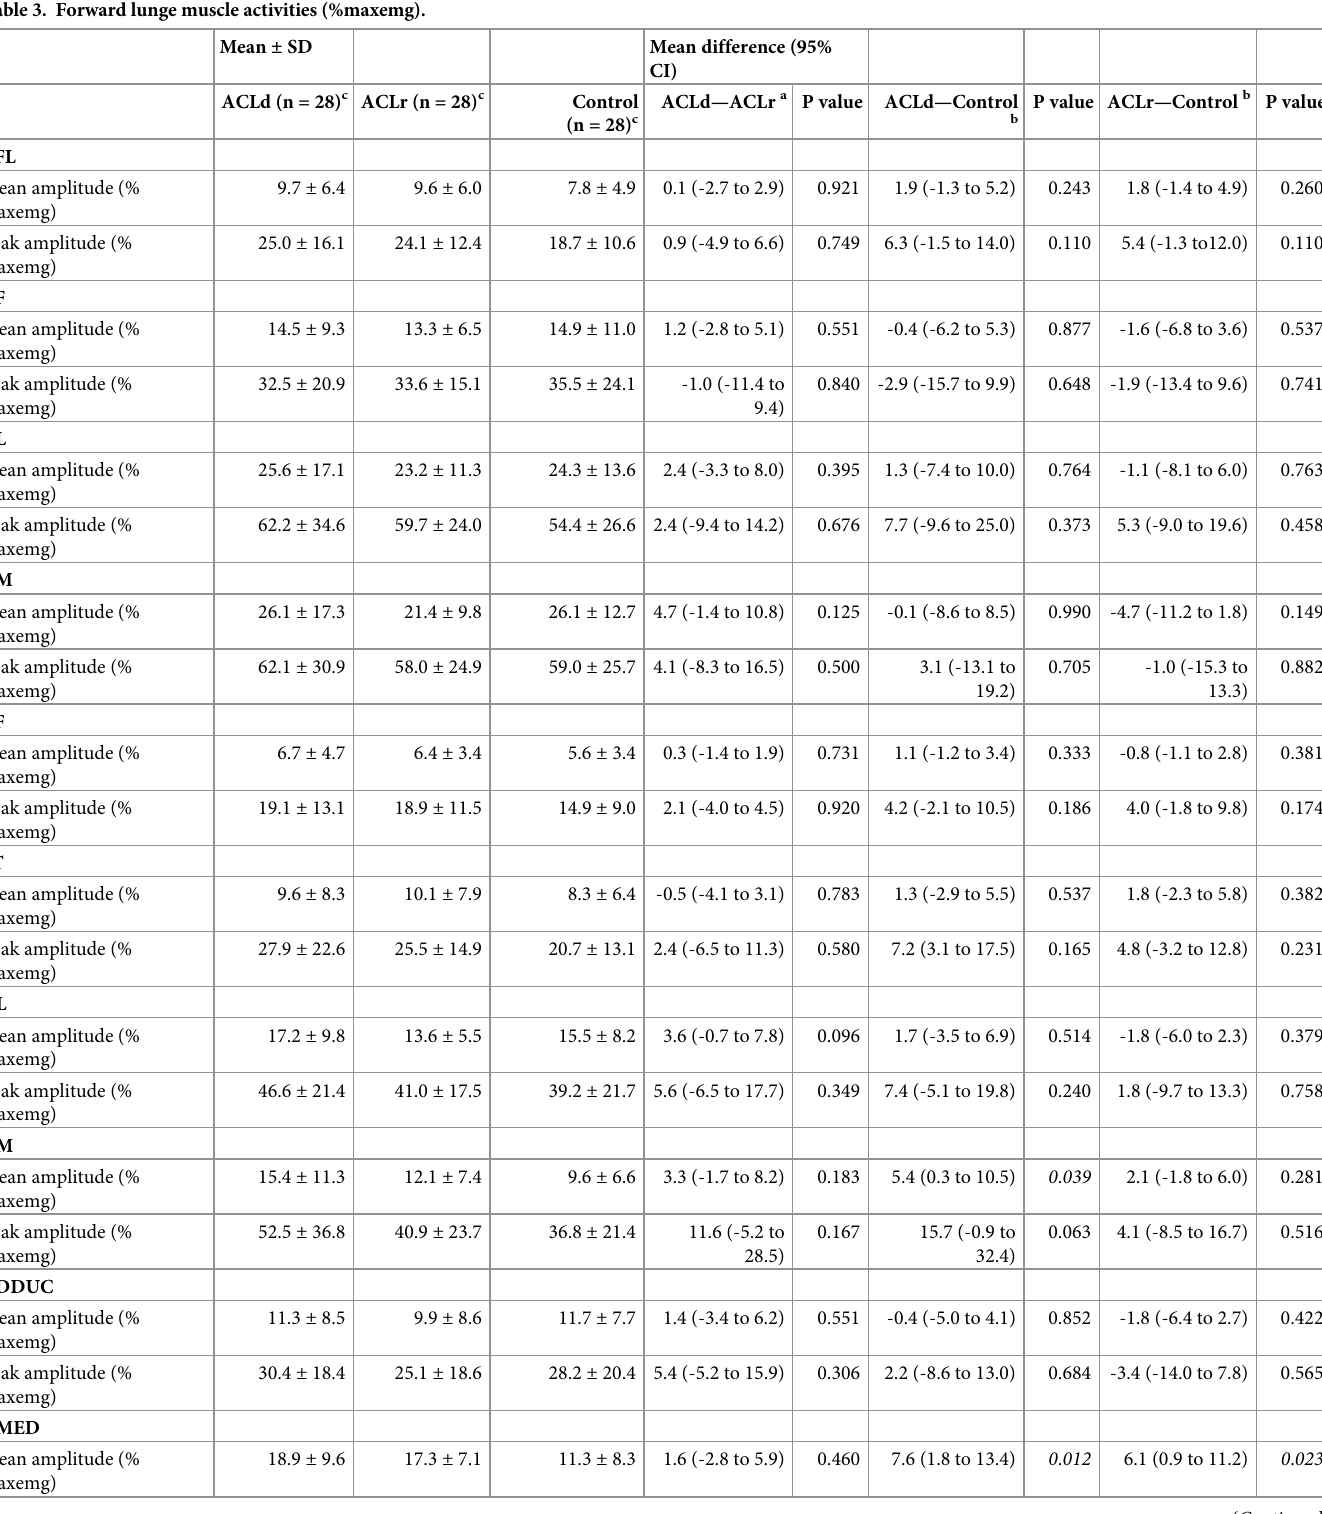
Table 3. Forward lunge muscle activities